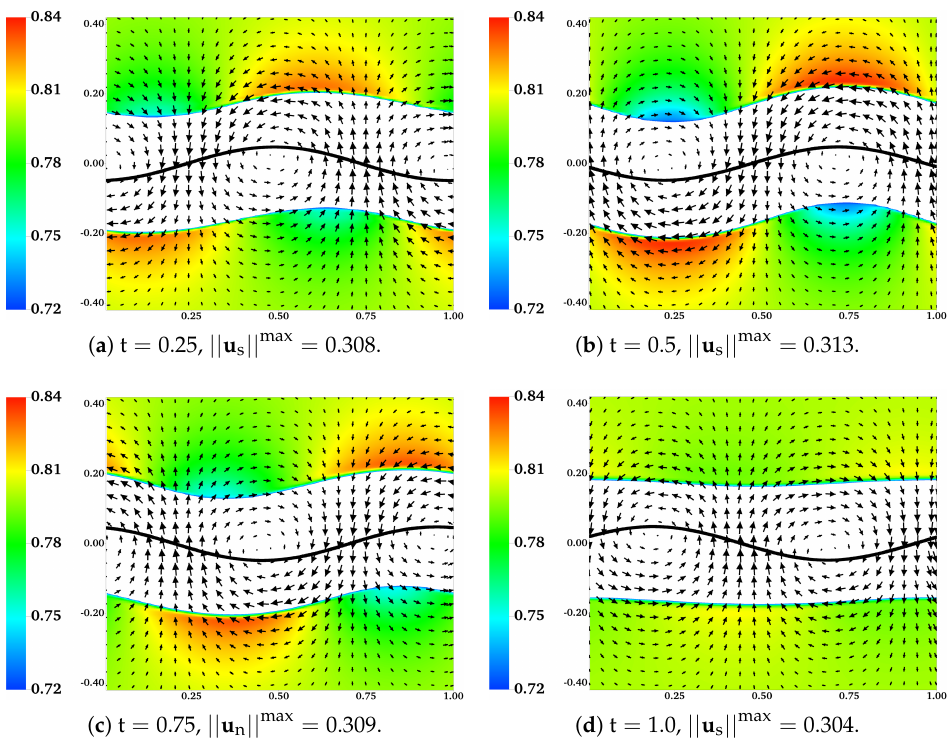
Figure 11. H = 0.16, β = 0.25, ξ = 100, θ i n n = 0.2, and θ o ut n = 0.8. Distributions of θ n and u s at different time. All vectors have the same scale.